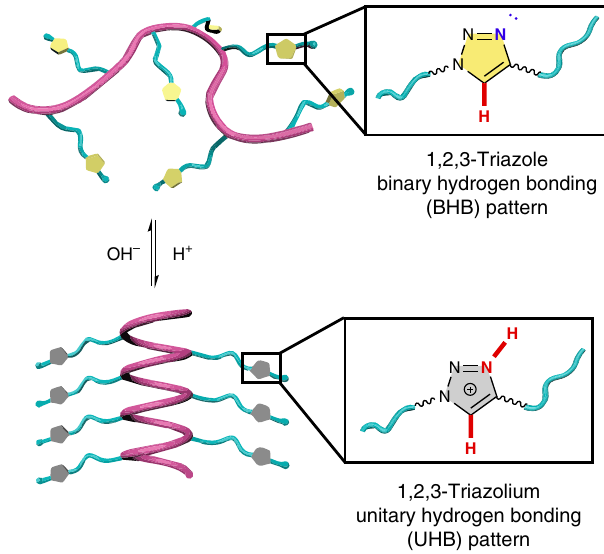
Fig. 1 Illustration showing the regulation of polypeptide conformation by H-bonding. The secondary structure of polypeptides were regulated through donor-acceptor transformation of side-chain H-bonding ligands. The protonation of 1,2,3-triazole (binary H-bonding pattern) to 1,2,3-triazolium (unitary H-bonding pattern) induced the coil-to-helix transition of the polypeptides. H-bond donors and acceptors are highlighted in red and blue ,